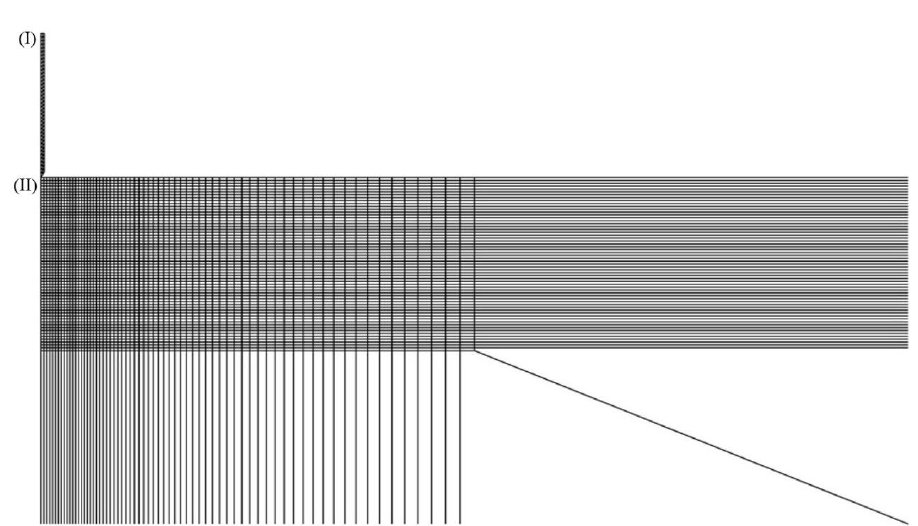
Fig. 1. Geometry of the axisymmetric model in ABAQUS: (I) pile, (II)